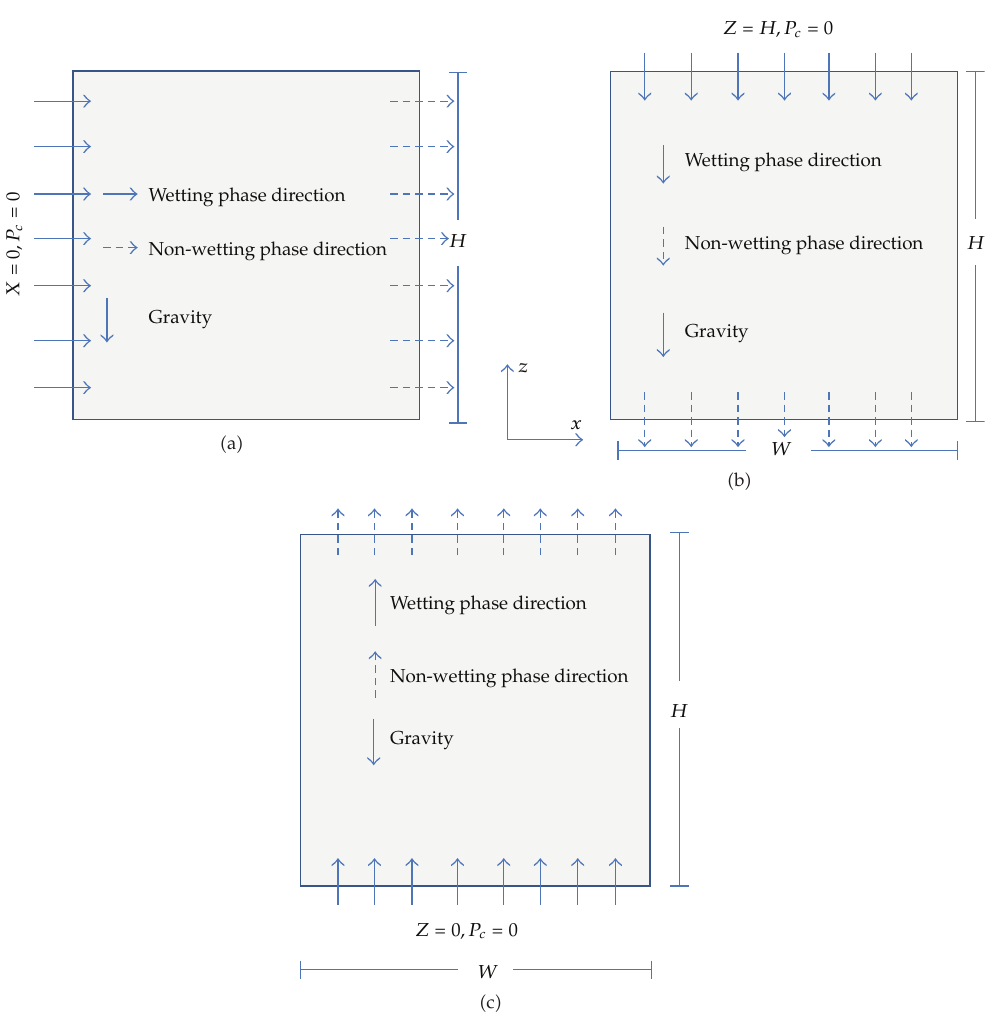
Figure 1: Schematic diagram of cocurrent imbibition for di ff erent inlet locations: (cid:3) a (cid:4) side, (cid:3) b (cid:4) top, and (cid:3) c (cid:4)